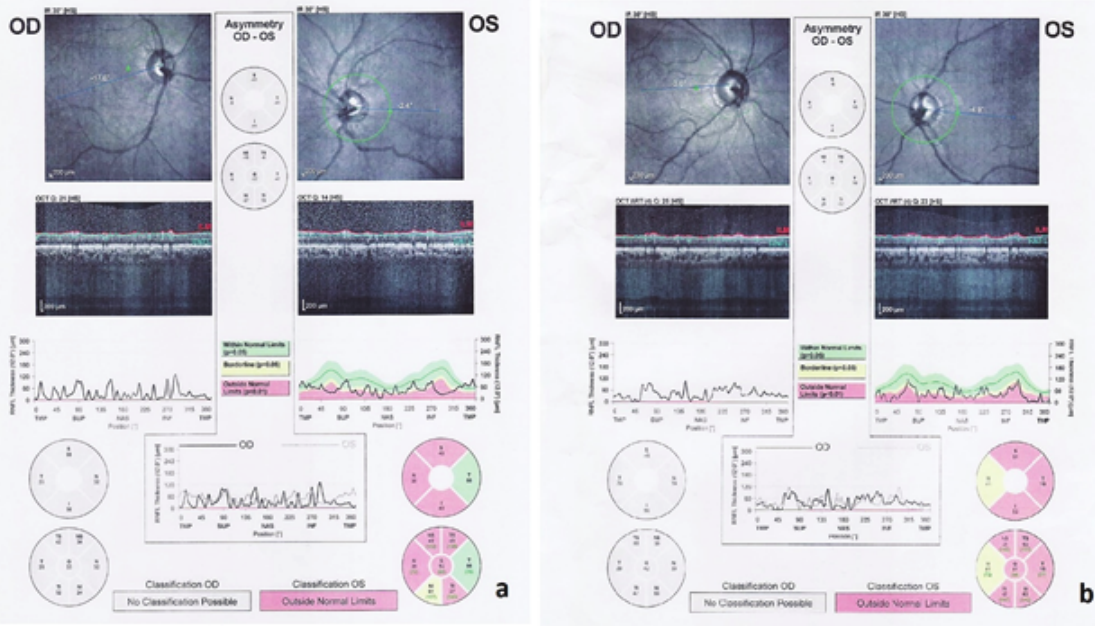
Figure 3. Severe nerve fiber layer loss in cases V.2 and